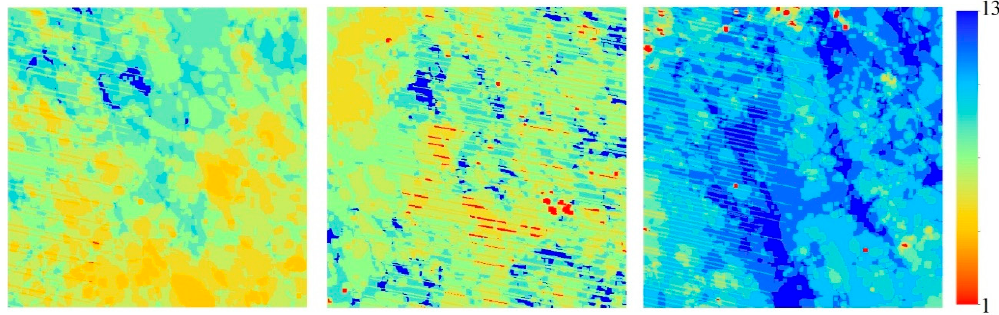
Figure 8. Spatial patterns in the number of valid observations in 2011 for the three study areas. ( left ): Minnesota; ( middle ): Iowa; and ( right ): New York.